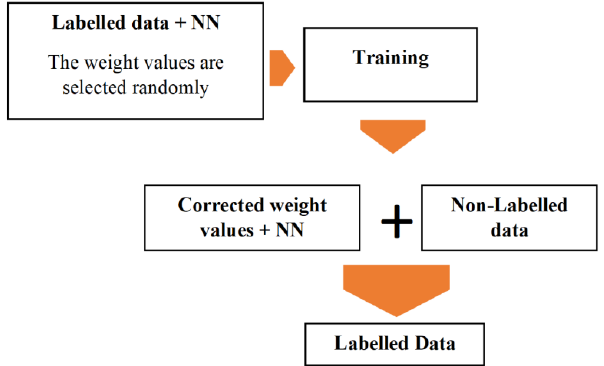
Figure 3. Deep learning functionality; NN is a Neural network.